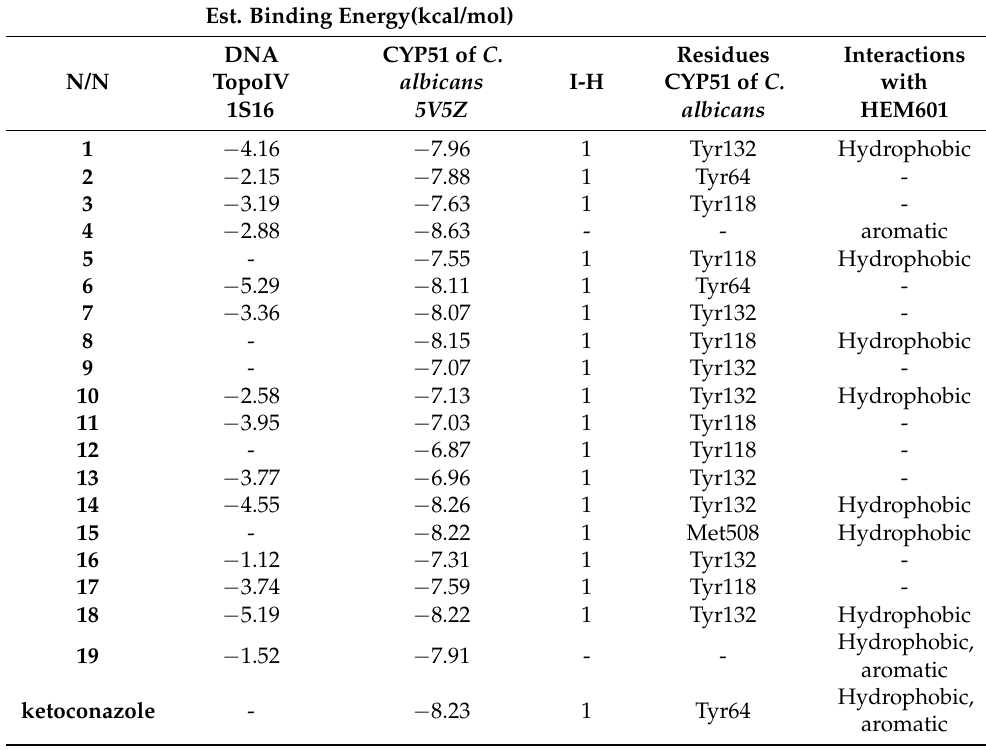
Table 7. Molecular docking results on antifungal